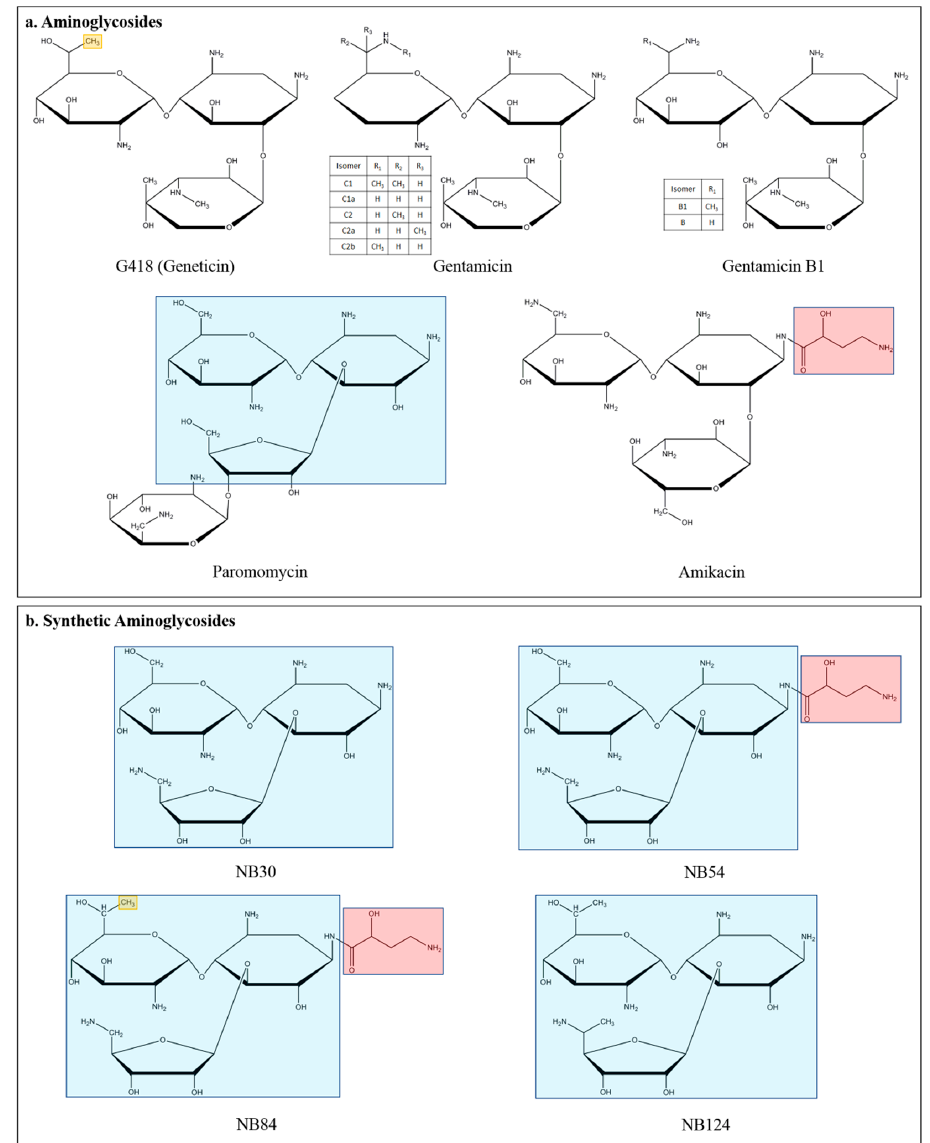
Figure 2. Chemical structures of aminoglycosides mediating PTC suppression. ( a ) Structures of antibiotic aminoglycosides: G418 (geneticin), gentamicin with its isomers, the two isomers of gentamicin B1, paromomycin, and amikacin. ( b ) Synthetic novel designer aminoglycosides: structural features of natural aminoglycosides paromomycin (the three ring pseudo ‐ trisaccharide backbone, in blue), amikacin (functional group called AHB on C10, in light red), and G418 (methyl group on C6 ′ , in yellow) were combined to produce designer aminoglycosides NB30, NB54, NB84, and NB124 [11,24].